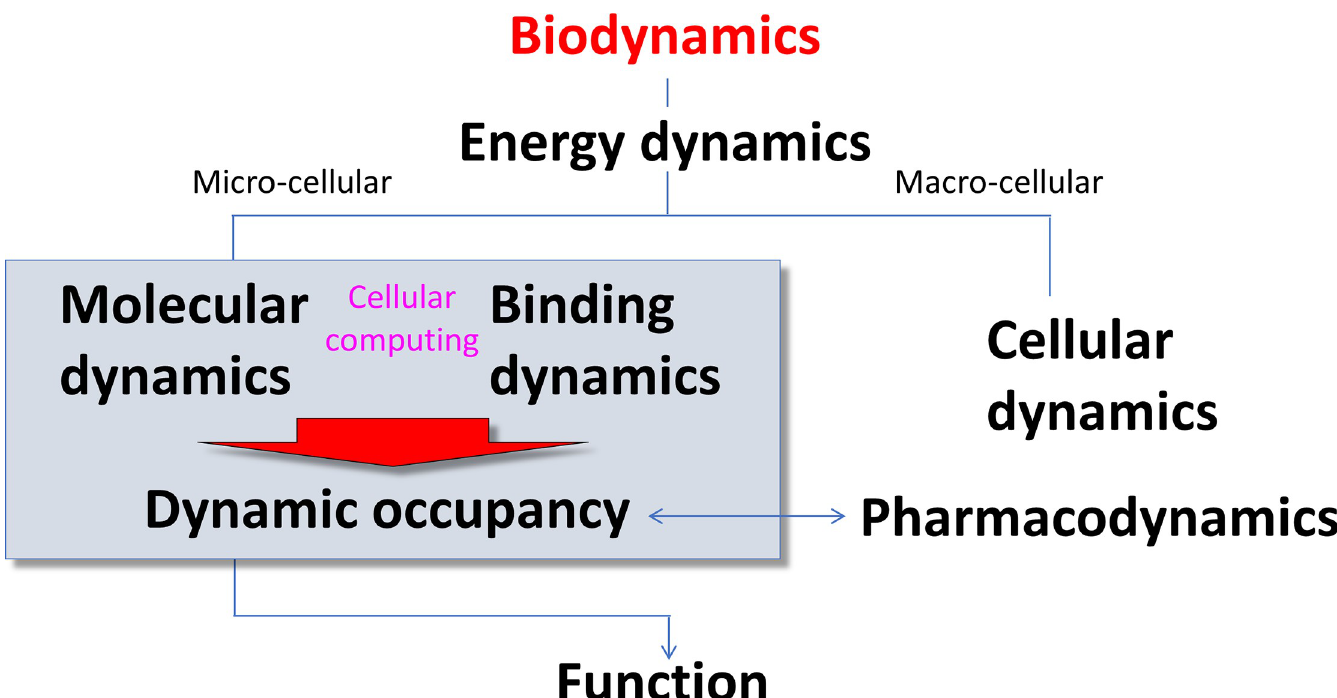
Fig 3. The six branches of biodynamics theory, which span the intra-/peri-cellular (micro-cellular) and macro-cellular levels (see text). Such processes can be simulated using multi-scale modeling approaches, ranging from atomistic molecular dynamics-based [1] to “atom-less” time-dependent ODE-based simulations (“MDE mimetics”) [1].